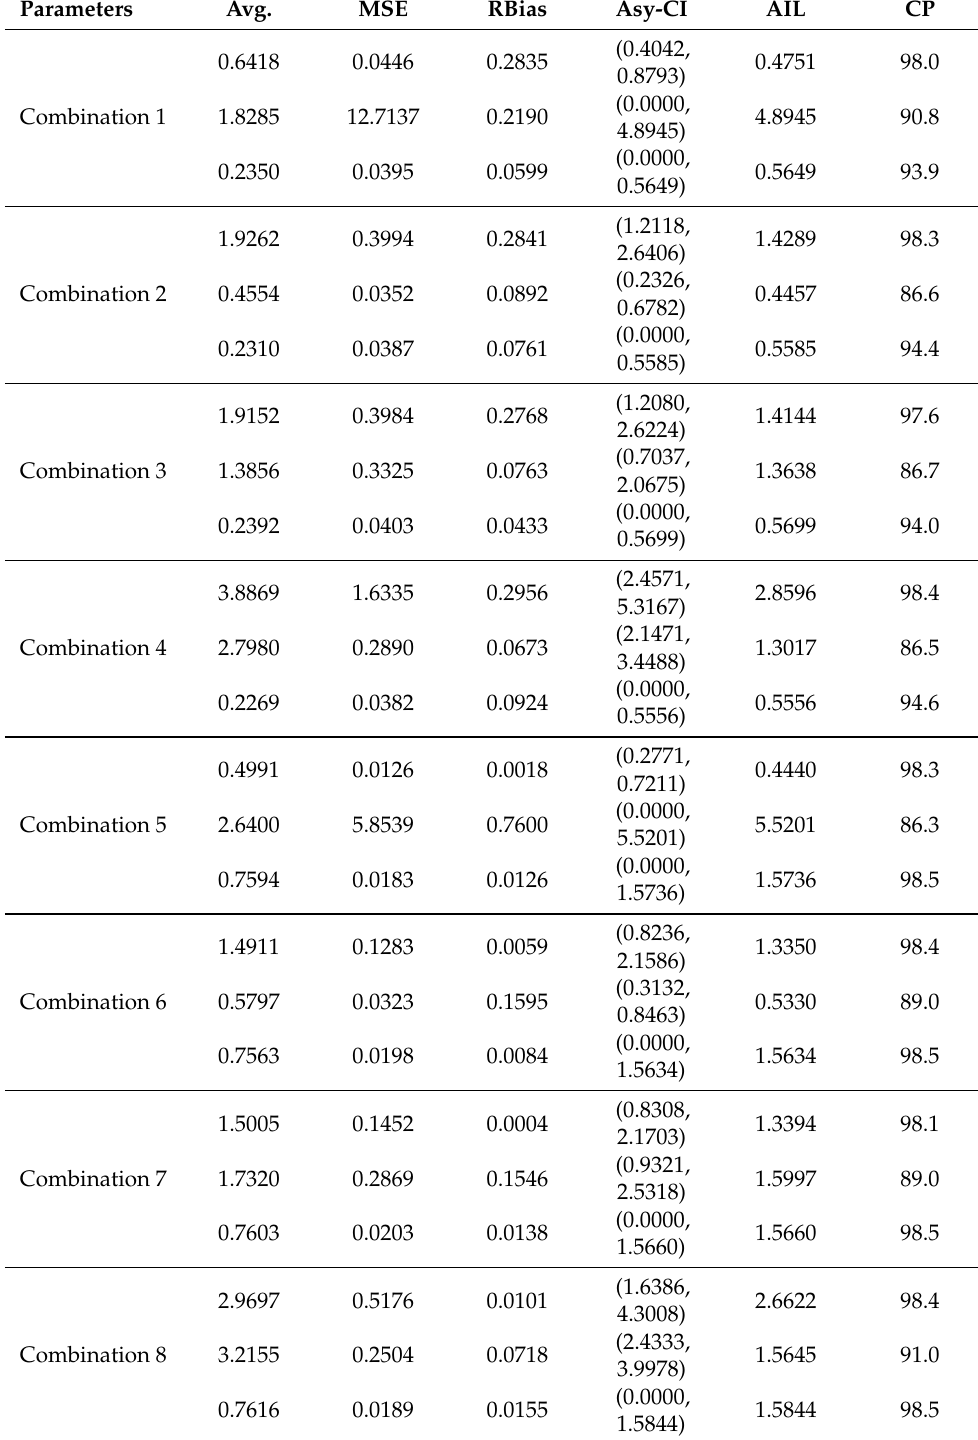
Table 12. Average estimated values, MSEs, CIs, AILs and CPs (in %) of the MLE for the FB distribution at N = 100 and n =